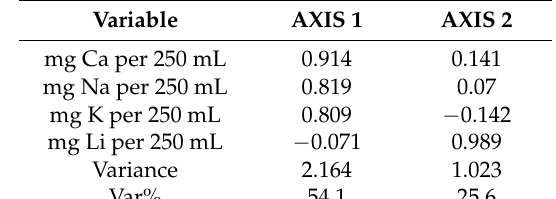
Table 2. Correlation coefficients between principal component analysis (PCA) axes 1 and 2 and the mineral concentration of MOL herbal preparations.